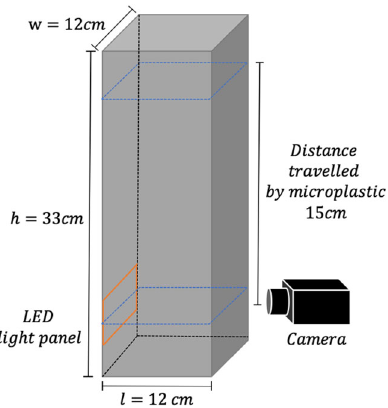
Fig. 5 Schematic of the Laboratory Spectral Flocculation Characteristics (LabSFLOC) experimental set-up. The set-up includes a plexiglass column of height 33 cm with a square cross section of 12 × 12 cm, fi lled with deionised water of